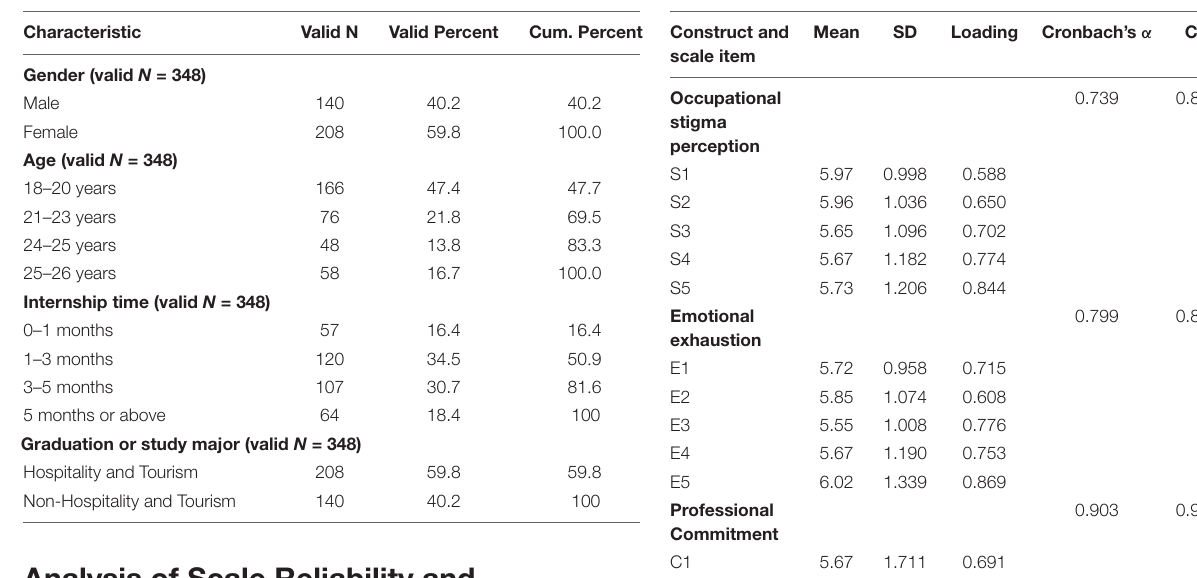
TABLE 4 | Sample’s descriptive statistical information. TABLE 5 | Analysis of scale reliability and convergence